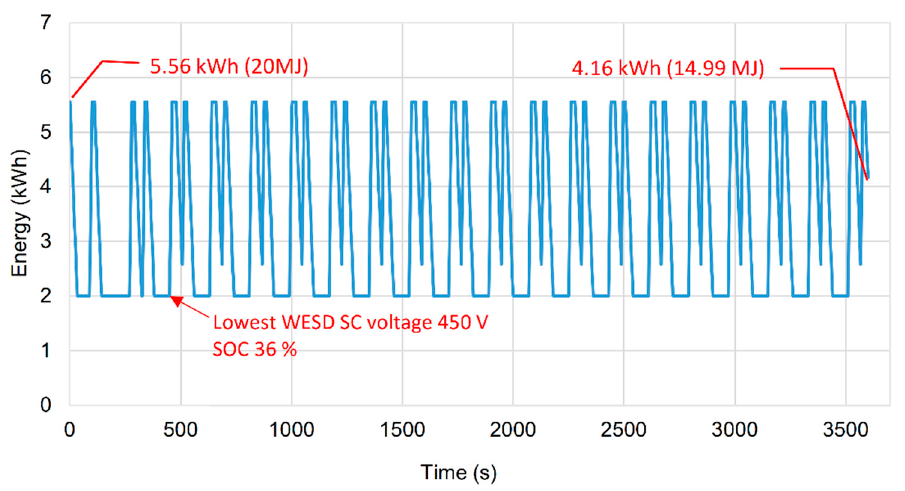
Figure 7. Simulation results (WESD energy). Energies 2020 , 13 , 2013